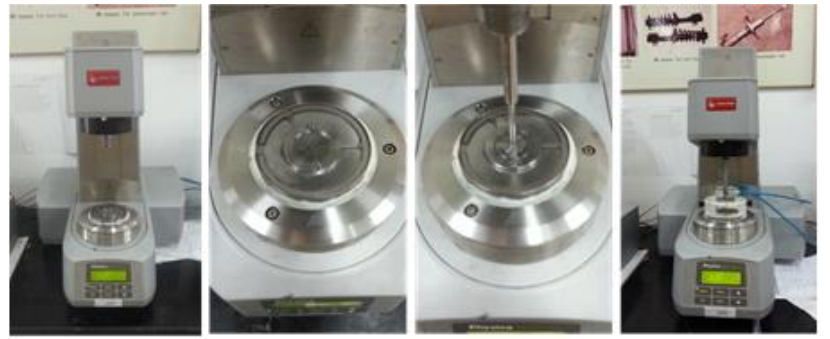
Figure 2. Experimental set-up and test process with MRC 301.